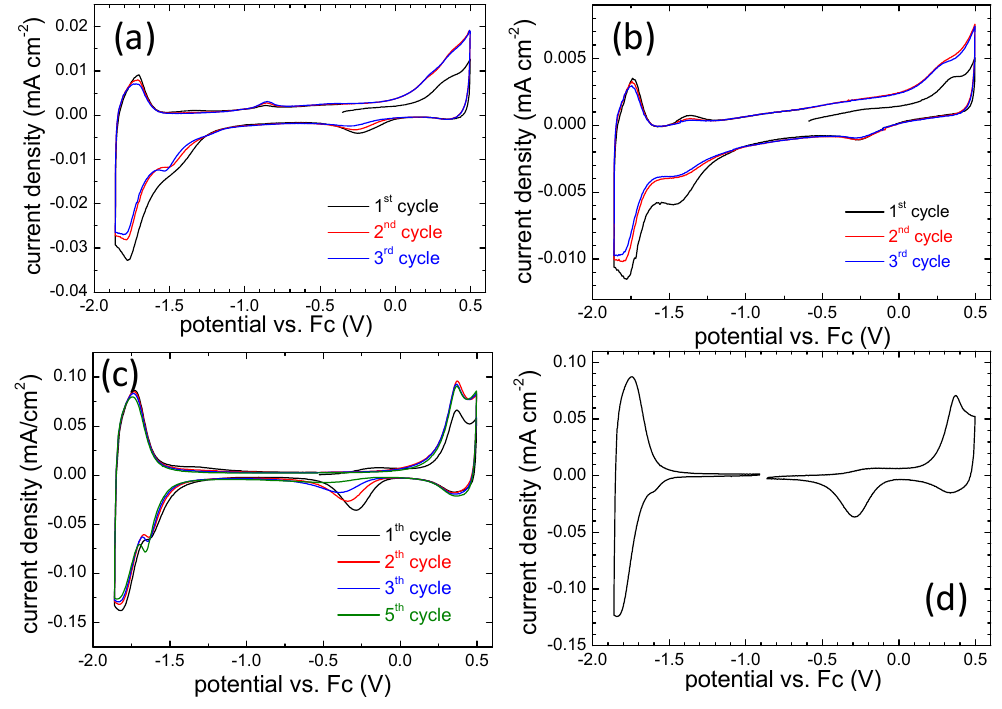
Figure 5. CVs (20 mV/s) of different poly(DEHT-V-BTD) in monomer free solution: sample obtained by: ( a ) CV; ( b ) PS; ( c ) and ( d ) PPS.